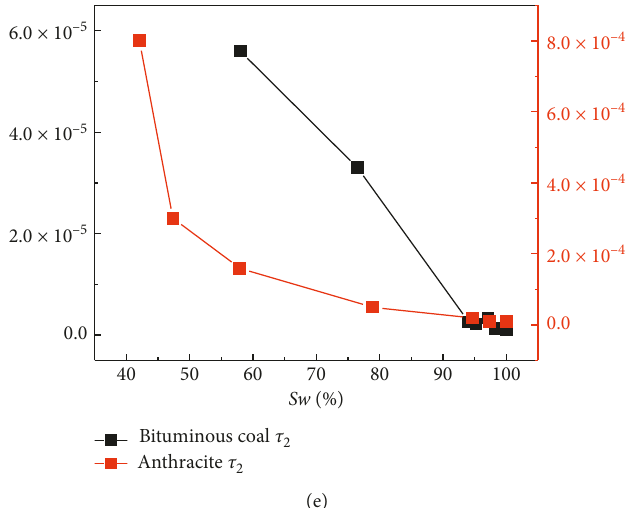
Figure 6: Varying relationship between parameters of the double Cole-Cole model and coal samples Sw: (a) m